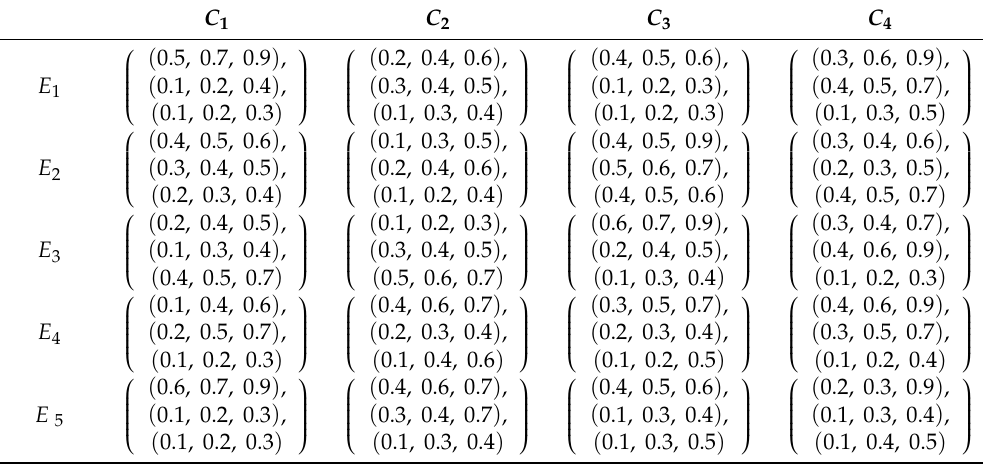
Table 1. TFNNs judgement matrix by the decision maker d 1